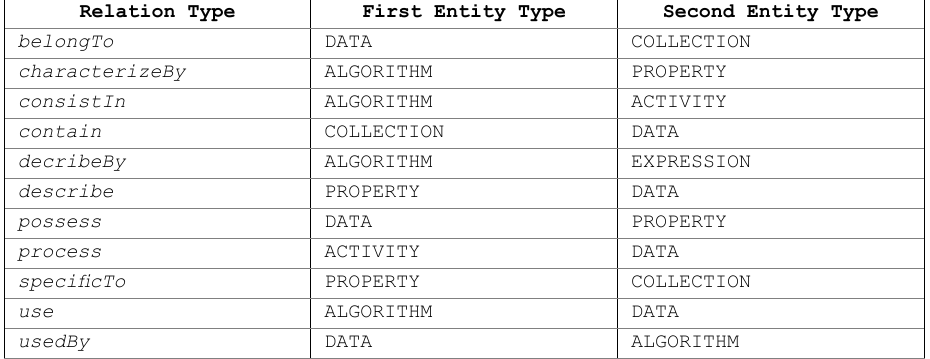
Table 1. List of relation types along with the entity types that are put in in relation Relation